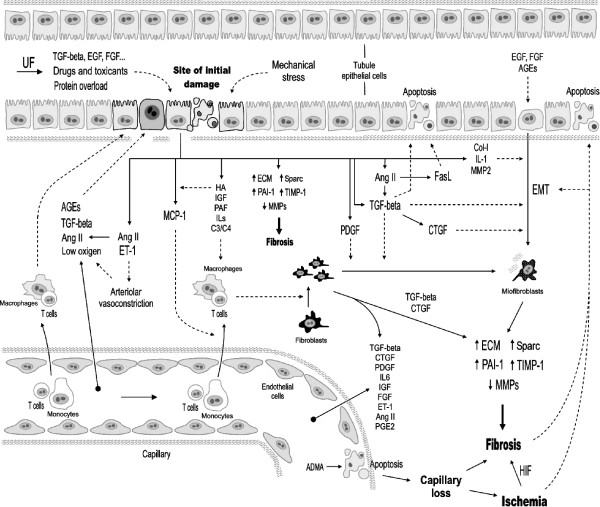
Extracellular mediators and effectors of tubulointerstitial pathological events in chronic kidney disease. ADMA: asymmetric dimethylarginine. HA, hyaluronic acid. C3 and C4, factors 3 and 4 of the complement. UF, ultrafiltrate.